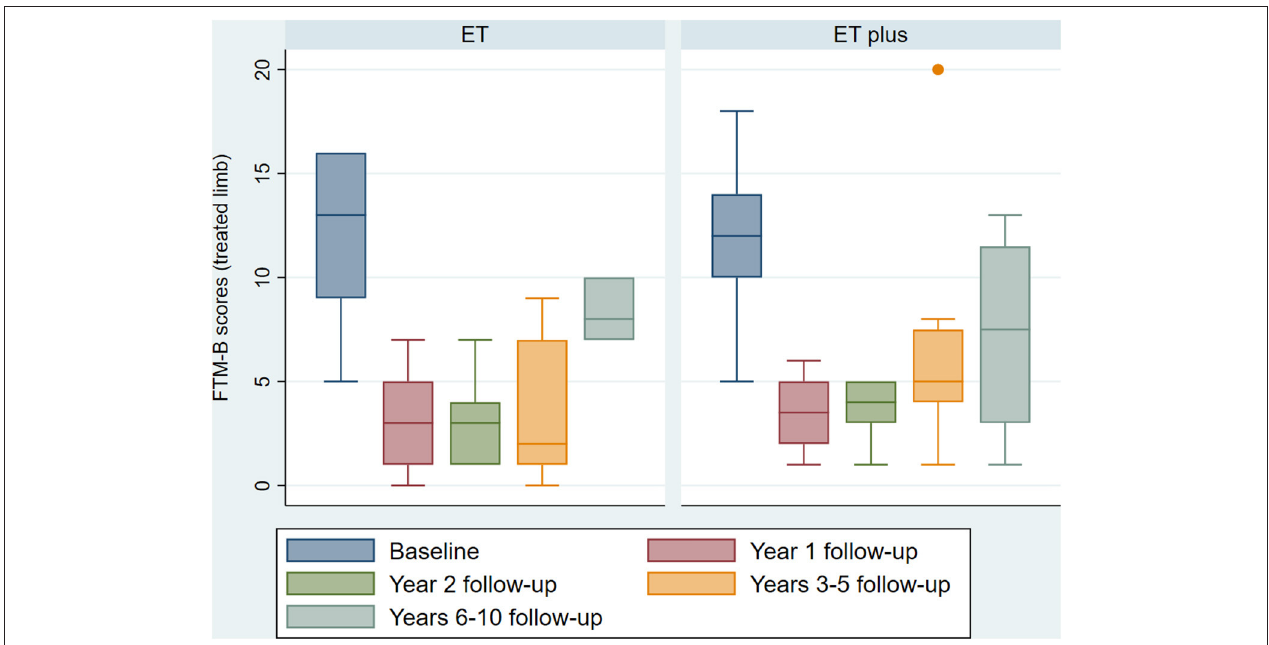
FIGURE 1 | ET vs. ET-plus outcomes. Boxplot of baseline and follow-up FTM-B scores at 1, 2, 3–5 and 6–10 years for the treated limbs of ET and ET-plus patients. One patient in the ET plus group lost benefit from DBS at 3–5 years, shown as the outlier. (ET, essential tremor; ET plus, essential tremor plus; FTM-B, Fahn-Tolosa-Marin Tremor Rating Scale-Part B).